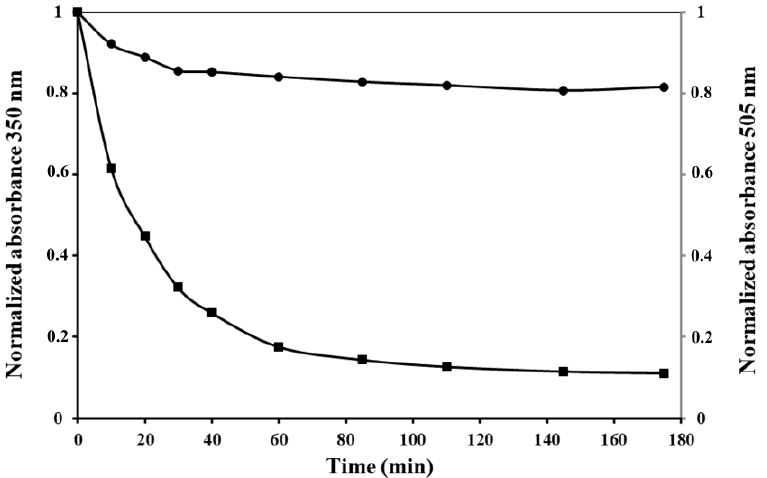
Figure 7. Proteinase K digestion of PldA-GFP IBs. Profiles of IBs fluorescence (circle) and turbidity (square).